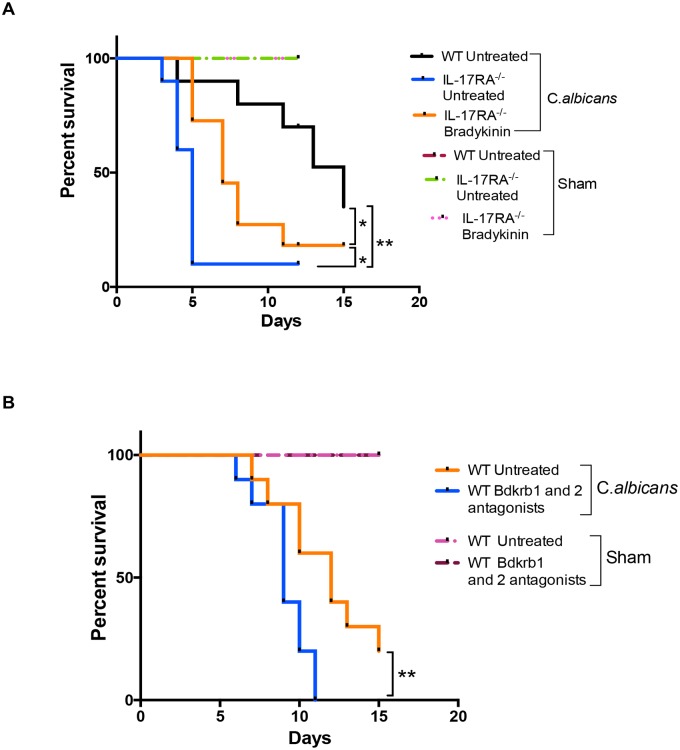
Bradykinin confers renal protection to IL-17RA-/- mice following disseminated C. albicans infection.
(A) IL-17RA-/- mice (n = 14) were treated with bradykinin (300 nmol/kg/day) or PBS starting on day -1 (relative to infection). On day 0, mice were administered C. albicans i.v. and evaluated for survival over 14 d. WT mice were infected with C. albicans and left untreated. Sham-infected IL-17RA-/- mice were given bradykinin only or left untreated (n = 3). (B) WT mice (n = 10–11) were treated with Bdkrb1 (R715; 1 mg/kg/day) and Bdkrb2 (HOE140; 1mg/kg/day) antagonists or PBS starting 1 day prior to infection and then daily for 14 d. Sham-infected WT mice were treated with the antagonists only (n = 3). Mice were evaluated for survival over 14 d. Data are pooled from 2 independent experiments for (A) and (B). P <0.05 (*), <0.01 (**).